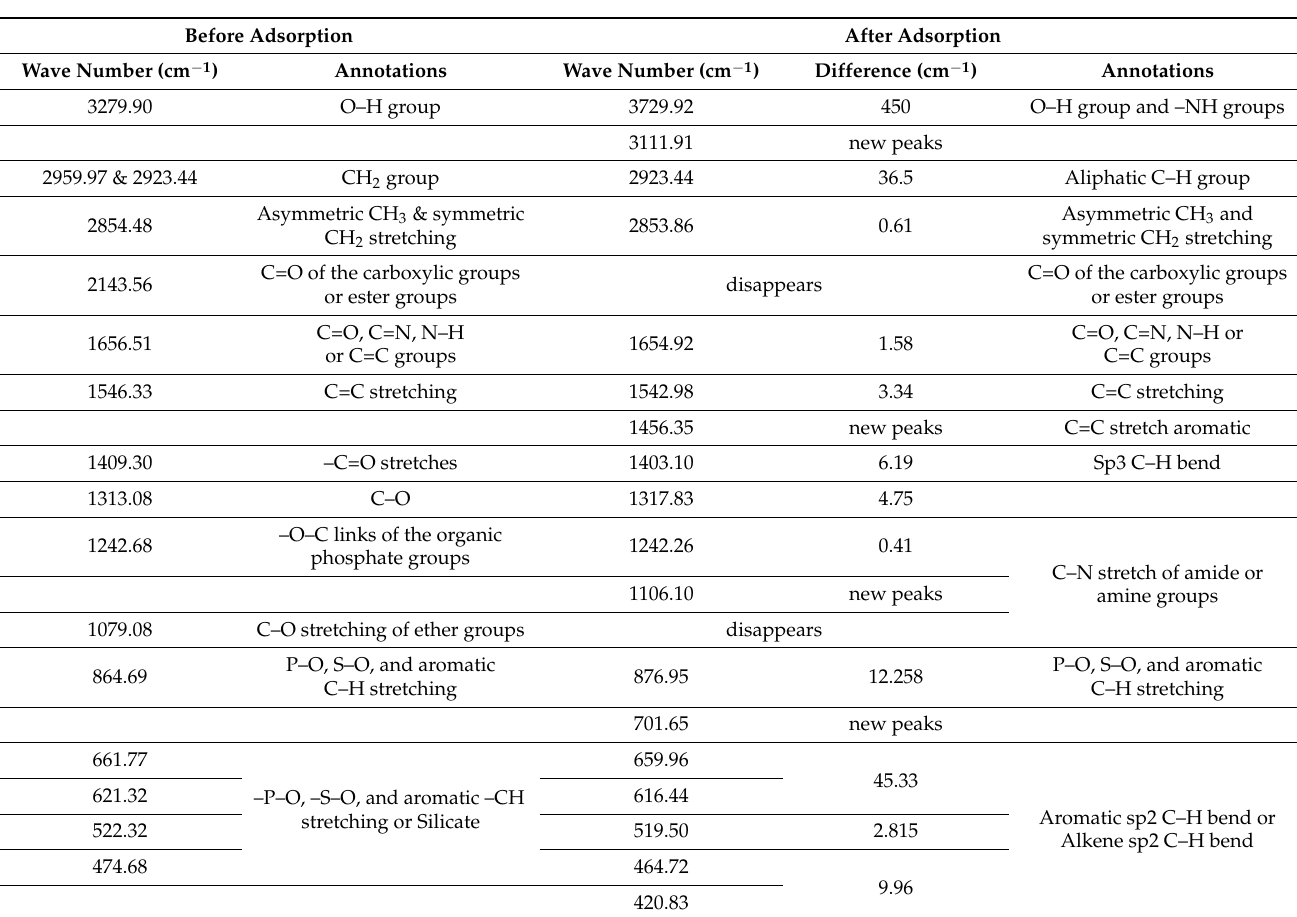
Table 1. Wavenumber and functional groups of FTIR spectroscopy investigation of A. platensis nanoparticles before and after sorption of